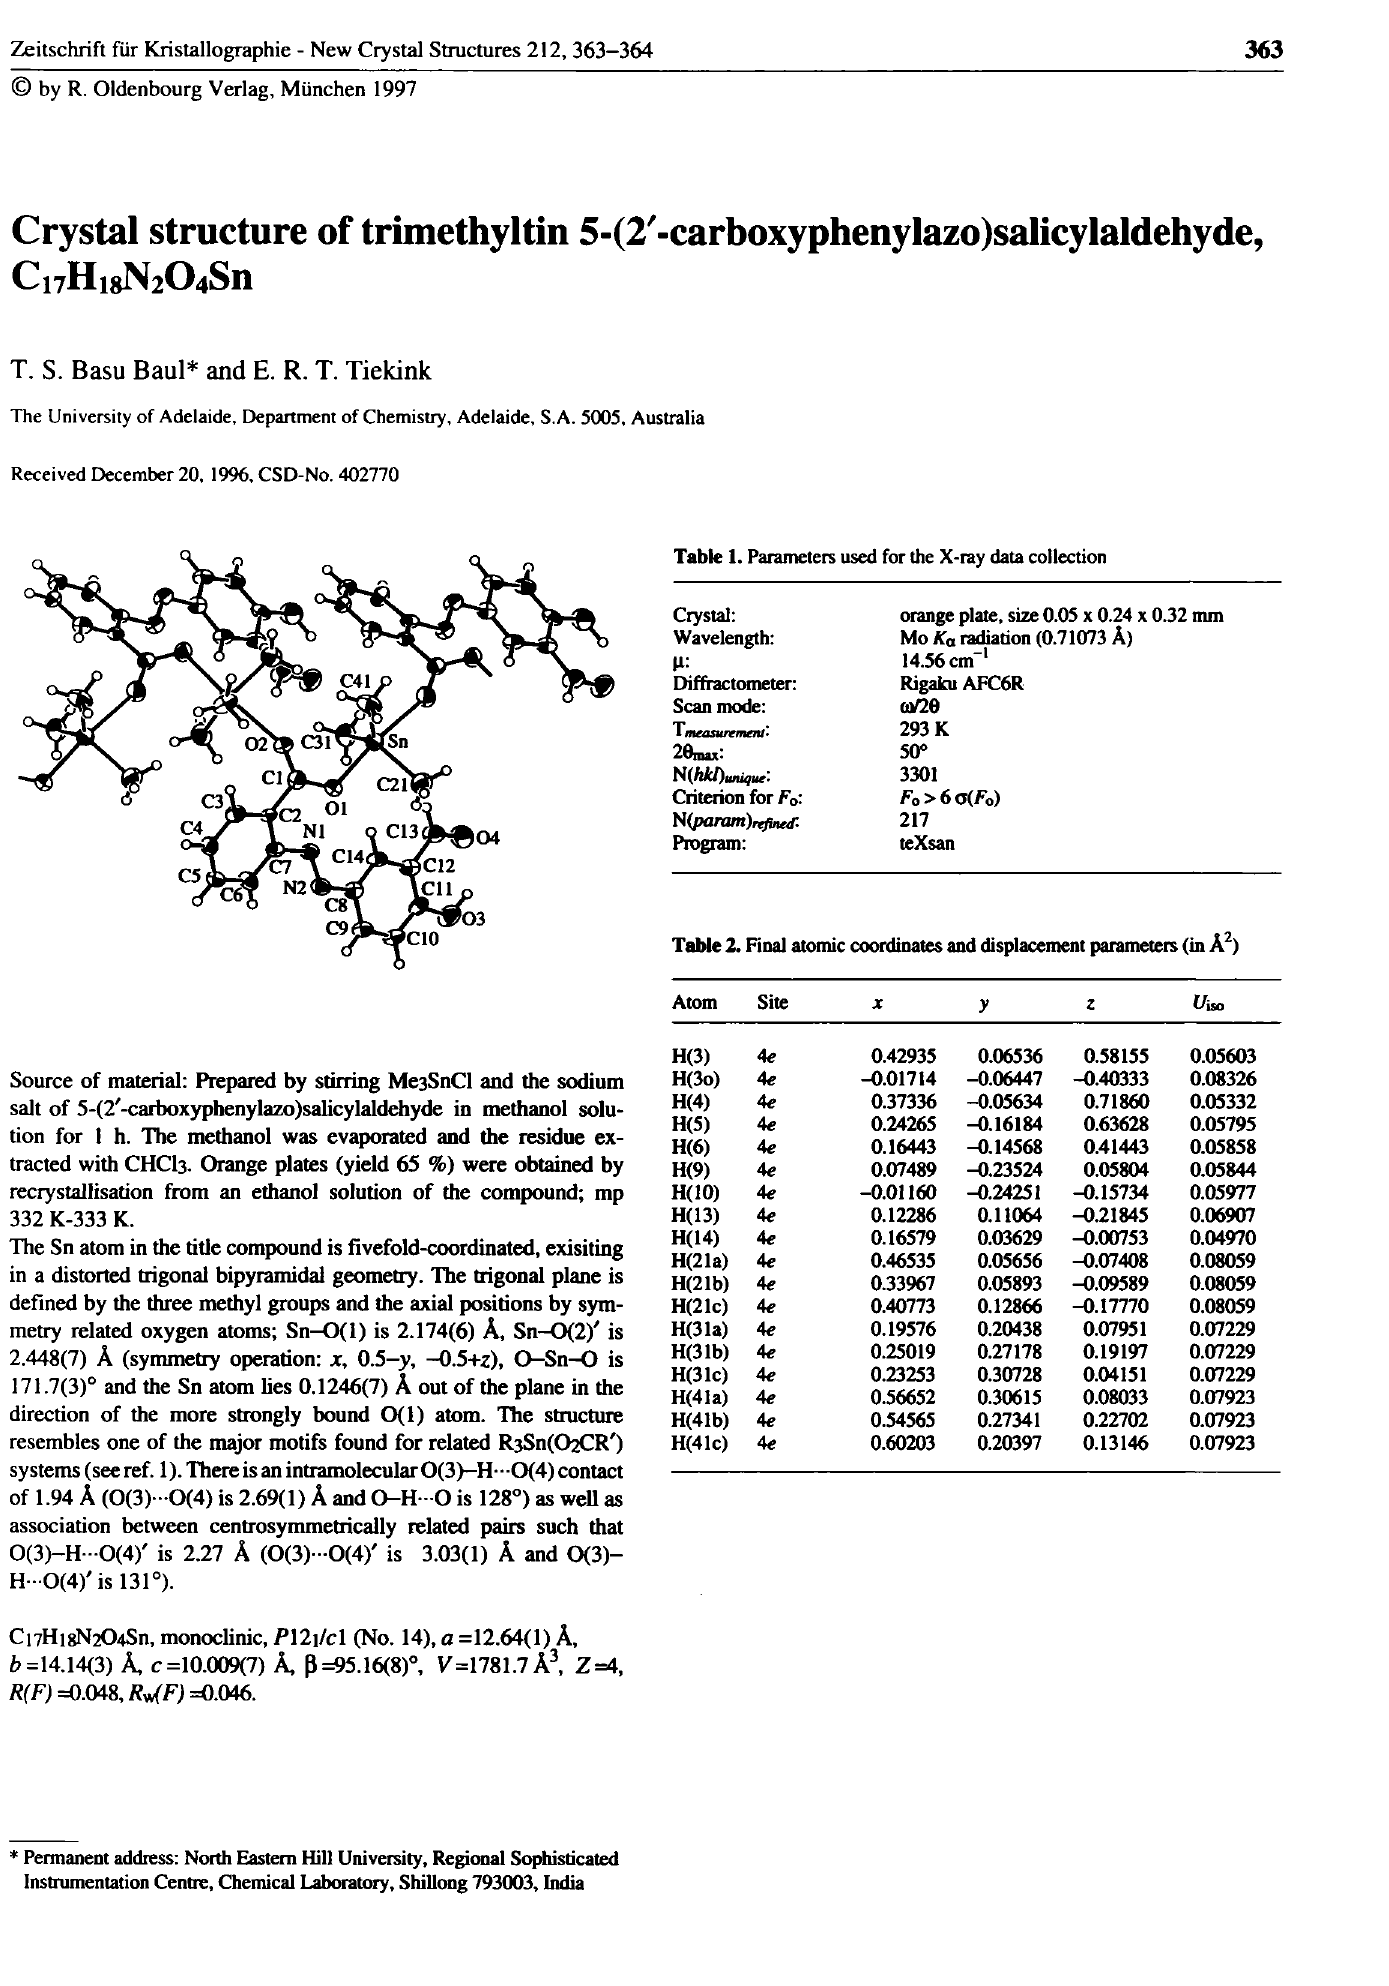
Table 1. Parameters used for the X-ray data collection